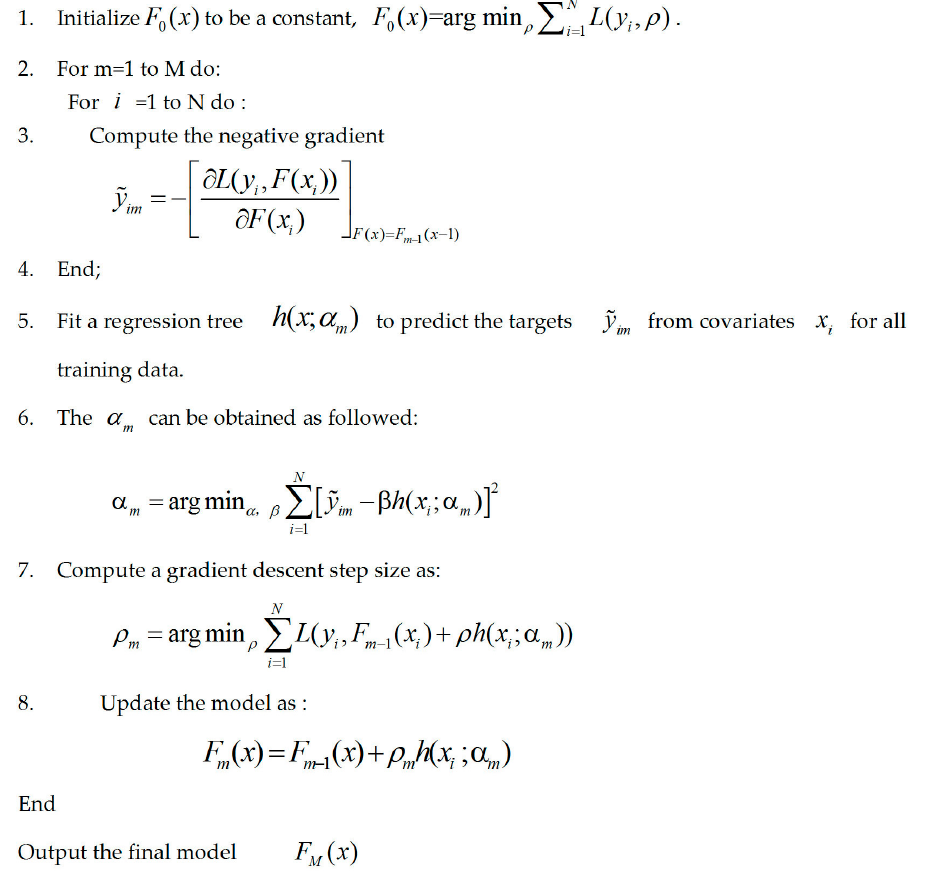
Figure 2. The main procedures of the gradient boosting regression tree (GBRT) method.